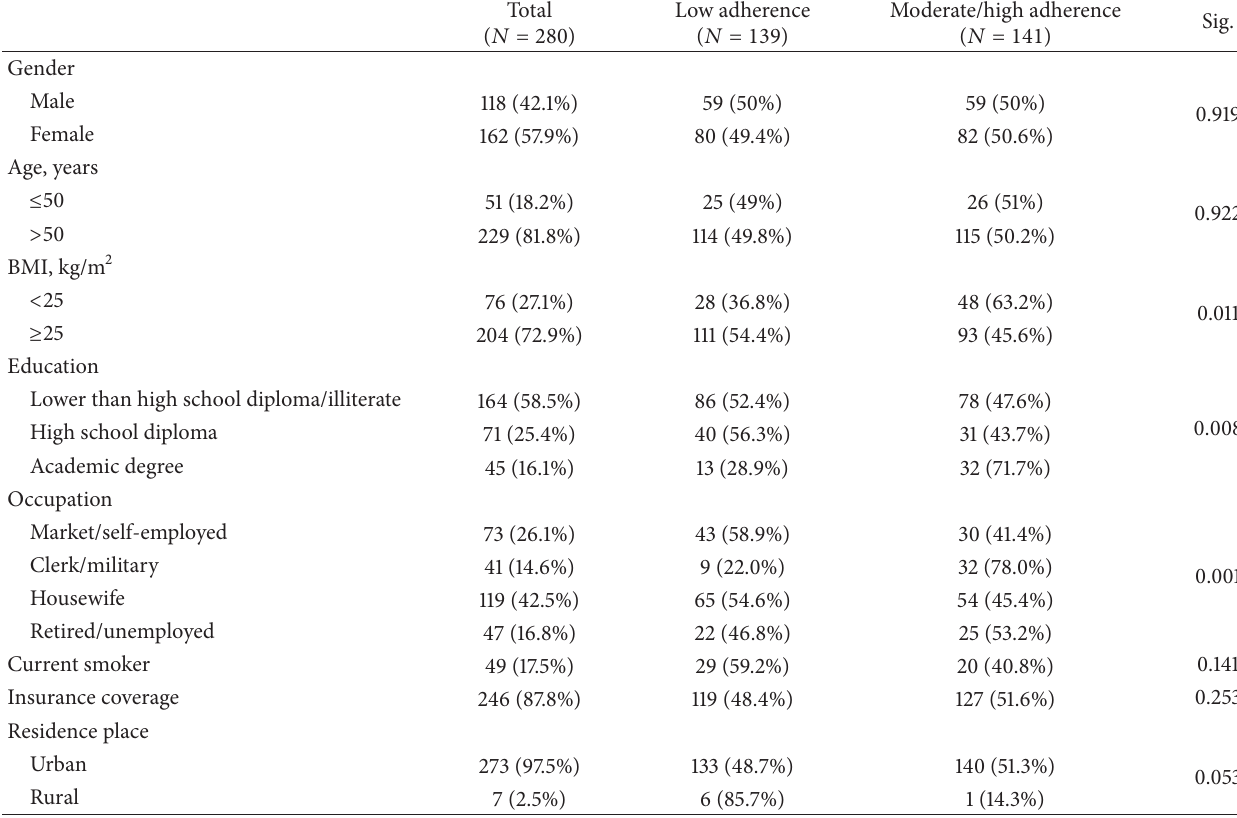
Table 1: Comparison of demographic characteristics between low and moderate/high adherence groups among 280 Iranian hypertensive